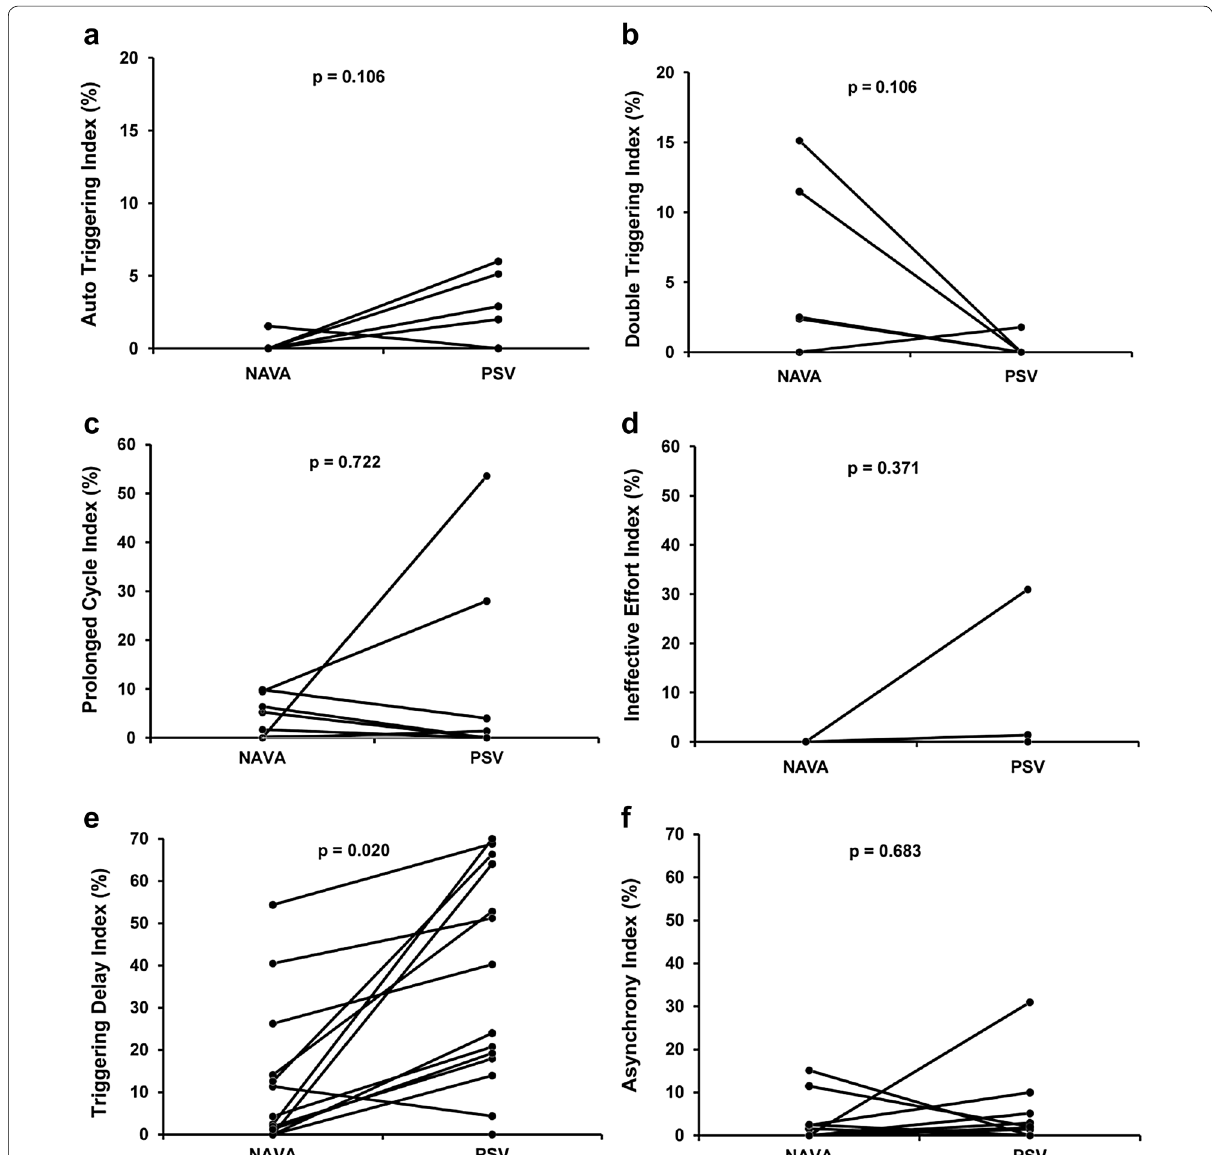
Fig. 2 Asynchrony analysis in NAVA and PSV. Lines represent each patient asynchrony index for each type of asynchrony. NAVA neurally adjusted ventilatory assist, PSV pressure support ventilation. p values obtained with the Wilcoxon signed‑rank test. The asynchrony index (AI) includes the following major asynchrony types: auto‑triggering, ineffective efforts, double triggering and short